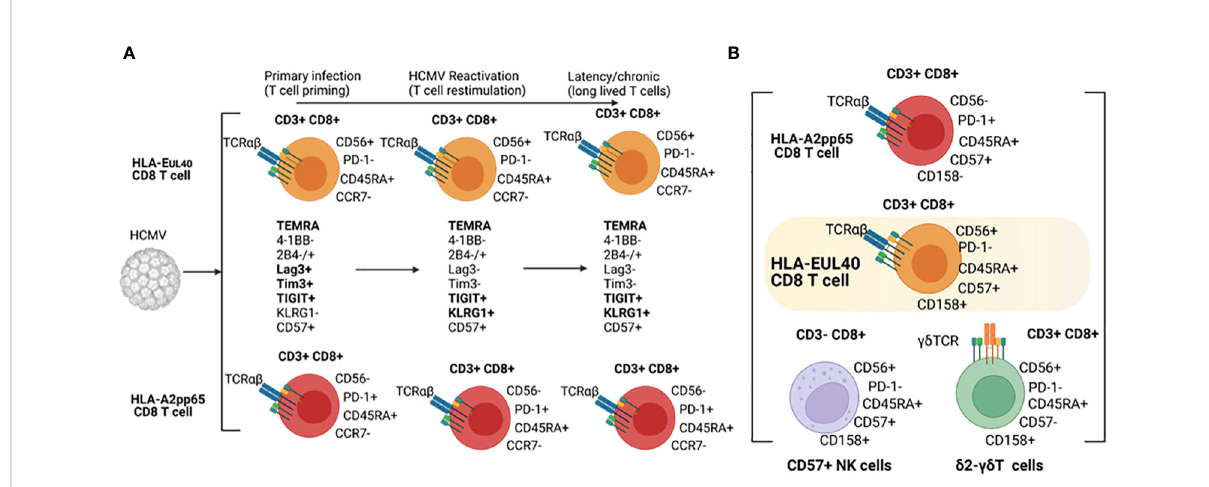
FIGURE 7 Phenotypical hallmarks of HLA-EUL40 CD8Tcells. (A) Phenotype of HLA-E UL40 CD8T in the course of HCMV infection and (B) Common phenotypic traits shared by HLA-E UL40 CD8T, CD8 ab T, d 2 - gd T and CD57 + NK